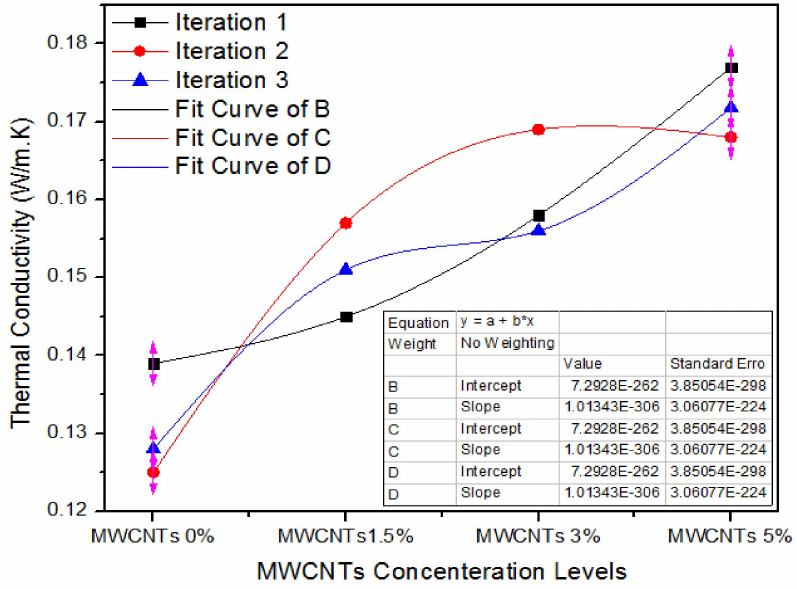
Figure 11. Thermal conductivity of a number of treatments of MWCNTs. For 0% MWCNTs, the three iterations values of thermal conductivity are 0.139, 0.125 and 0.128 W/m. K, and for 1.5% MWCNTs, the three iterations values of thermal conduc- tivity are 0.145, 0.157 and 0.151 W/m. K. On the contrary, for 3.0% MWCNTs, all the three iterations have 0.158, 0.169 and 0.156 W/m. K thermal conductivity values. As the ab- sorption level escalates from 3.0% to 5.0% the thermal conductivity values of 0.177, 0.168 and 0.171 W/m. K demonstrate a trivial decline for all counts.